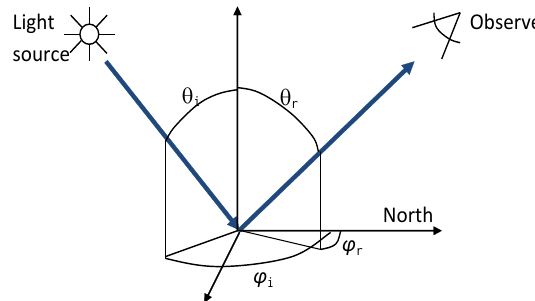
Figure 1. Bidirectional reflectance geometry. θi, φi and θr, φr are angles of incident and reflected light,